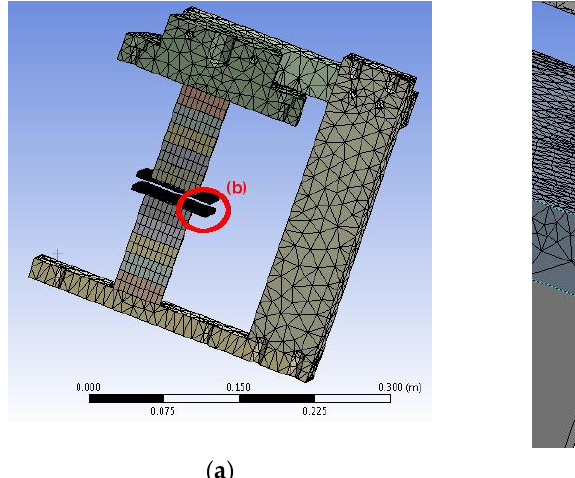
9 of 24 Figure 8. The shaped abrasive tool during the machining: 1—work piece, 2—flexible abrasive tool, 3,4—permanent magnets. 3. Results and Discussion 3.1. Simulation